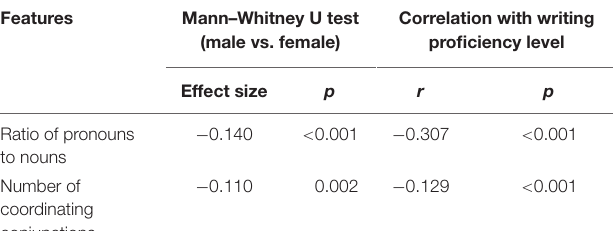
TABLE 3 | Distinctive cohesion features between the two gender groups. Features